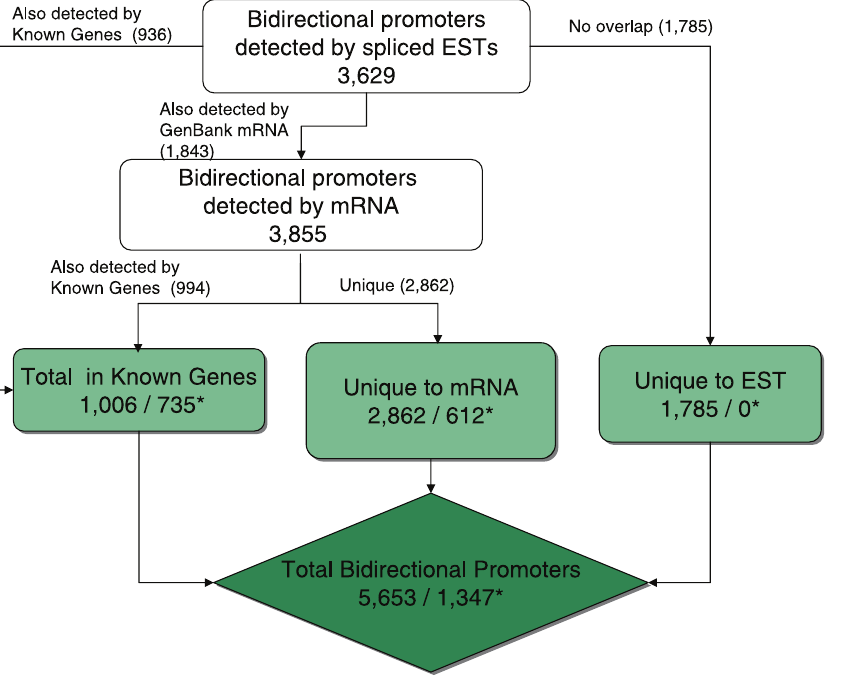
Figure 1. Identification of Bidirectional Promoters The diagram depicts how bidirectional promoters were identified from the UCSC Human Genome Browser annotations, including Known Genes, mRNA, and spliced ESTs. The number of previously identified bidirectional promoters for each category is marked with an asterisk (*) for comparison. Promoters identified from more than one source were counted only once. Priority was given to promoters identified from Known Genes followed by GenBank mRNA, and then spliced ESTs.